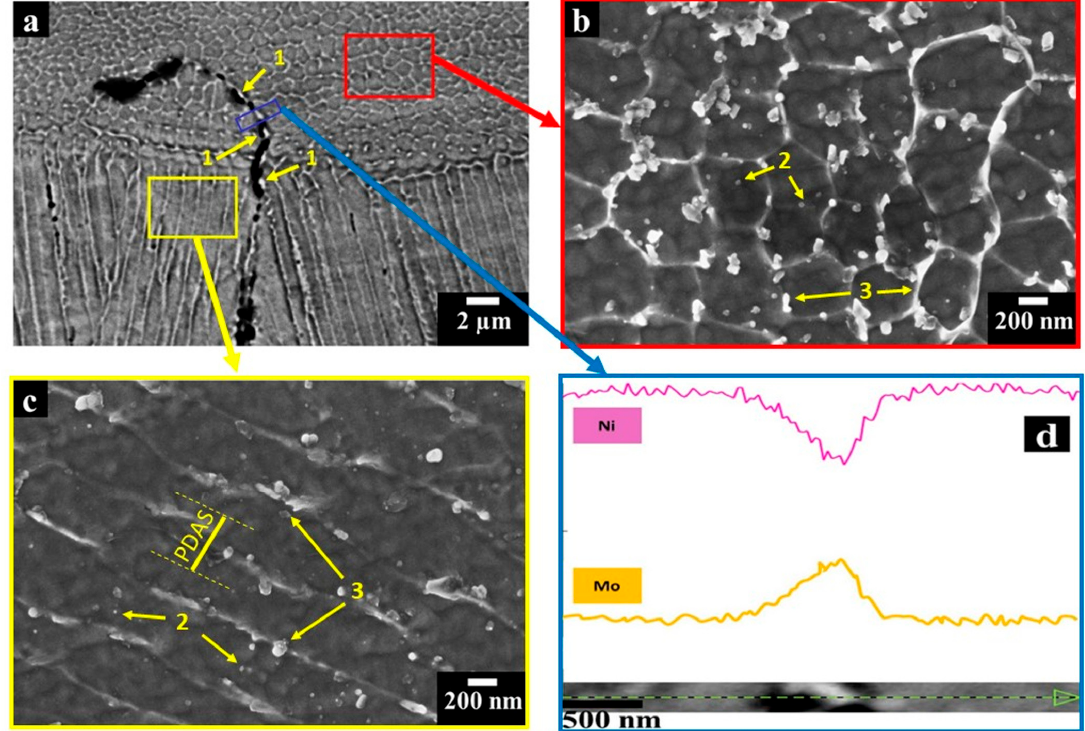
Figure 5. SEM images of HX samples showing ( a ) very fine cellular and columnar dendritic structures as well as an intergranular crack and bright phases indicated by arrows 1, taken in BSE mode; ( b , c ) cellular and columnar dendrites with sub-micrometric primary dendrite arm spacing (PDAS) exhibiting very fine Mo-rich carbides within dendritic core indicated by arrows 2 together with globular and elongated carbides pointed out by arrows 3 within interdendritic areas, taken in secondary electron (SE) mode; ( d ) EDS line scan of the bright phases along the cracks showing that the precipitates were enriched in Mo and depleted of Ni.